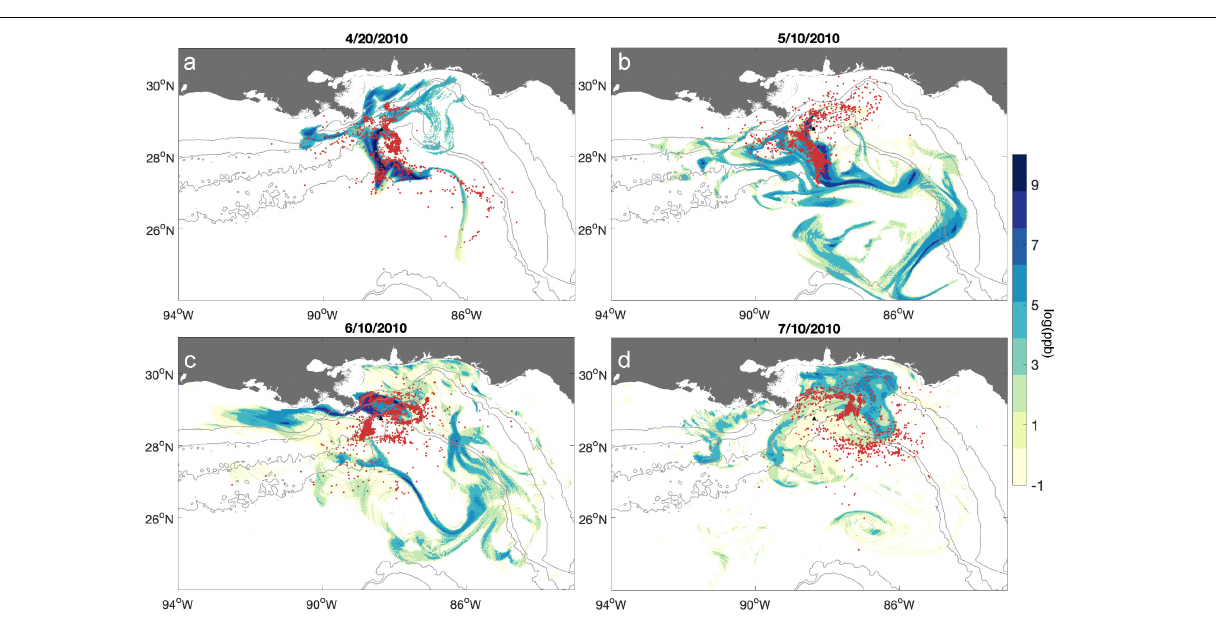
FIGURE 2 | Photooxidized components (POCs, red dots) probable formation locations, for four release days along the DWH oil spill timeline: (a) April 20th, 2010, (b) May 10th, 2010, (c) June 10th, 2010 and (d) July 10th, 2010. The background colors illustrate the oil concentration (log ppb) at the surface layer (0 to 1 m depth) 20 days after each release date. POCs are considered to form when droplets received a cumulative irradiance dose of at least 6.60*10 7 J m − 2 (Ward et al.,